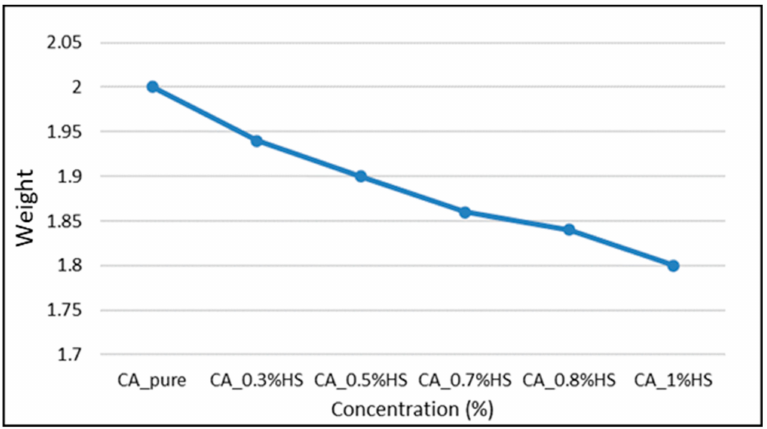
Figure 6. Tensile testing samples’ average